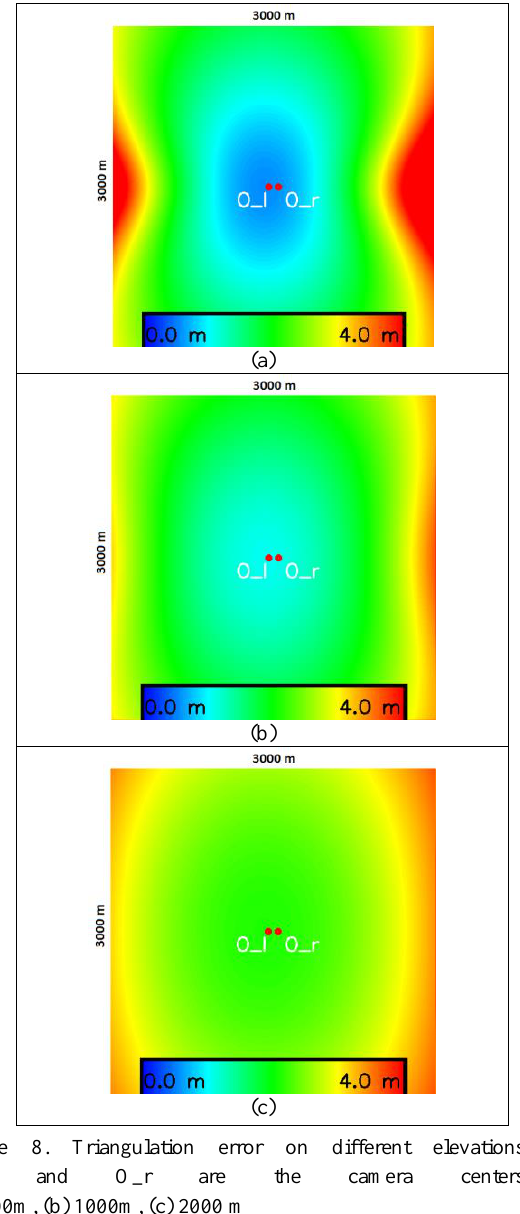
Figure 9. Pyramidal Random Dot Stereo Image